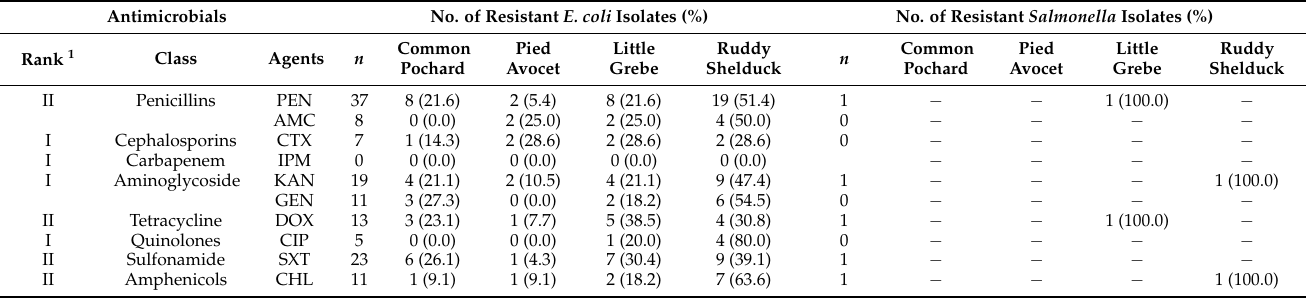
Figure 1. Distribution and clustering of Escherichia coli , Salmonella typhimurium, and Staphylococcus isolates recovered from different species of migratory wild birds around the Al-Asfar Lake. ( a ) Heat map representation of antimicrobial-resistant profiles of the 90 Escherichia coli and 5 Salmonella typhimurium isolates. ( b ) Heat map representation of antimicrobial-resistant profiles of the 37 Staphylococcus isolates. Table 2. The antimicrobial-resistant profiles of Escherichia coli ( n = 90) and Salmonella typhimurium ( n = 5) isolates recovered from migratory wild birds around the Al-Asfar Lake.